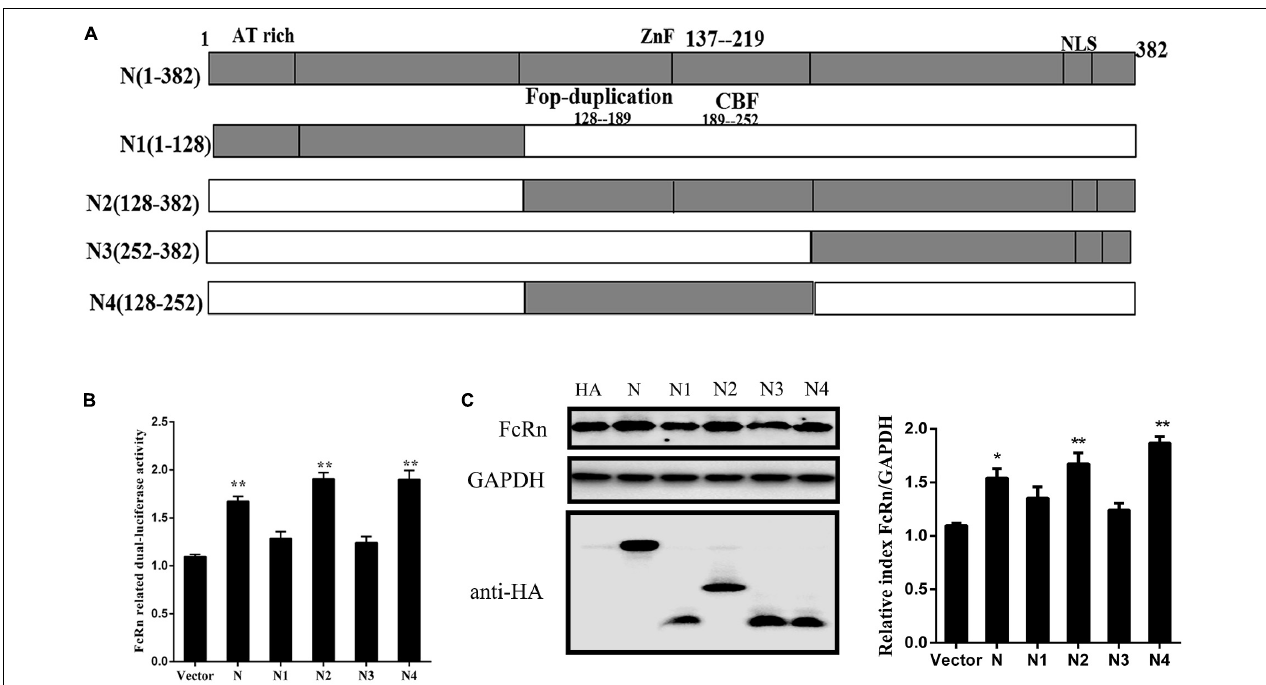
FIGURE 5 | Schematic representation of the TGEV N-protein serial-deletion mutant constructs. (A) Schematic representation of the TGEV N-protein serial-deletion mutant constructs. (B) IPEC-J2 cells were co-transfected with pRL-TK, FcRn-Luc, and TGEV N deletion-mutant expression plasmids. The cell lysates were harvested for dual luciferase assays at 24 hpi. (C) IPEC-J2 cells were co-transfected with TGEV N deletion-mutant expression plasmids for 36 h and protein expression in cell lysates was measured by Western blot using anti-HA antibody and anti-FcRn antibody. The right panel represents the quantification of the bands by densitometry, corrected by the amount of GAPDH. ∗ p < 0.05, ∗∗ p <